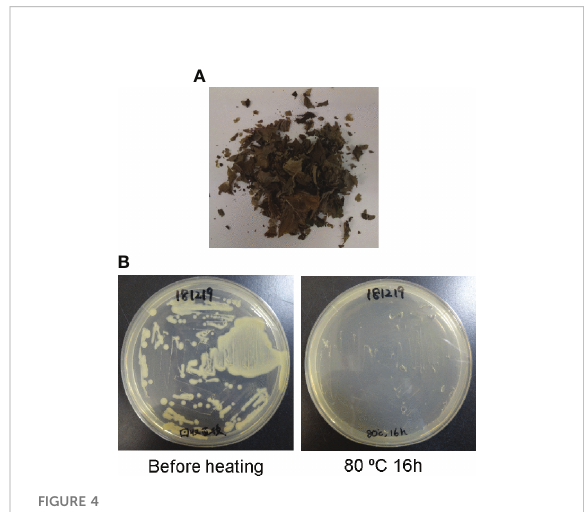
FIGURE 4 Agrobacterium was killed by heat treatment (80°C, 16 h). (A) After incubation at 80°C, the leaves were completely dried. (B) After agro-in fi ltration, Agrobacterium was alive in N. benthamiana leaves (before heating). After incubation of leaves at 80°C for 16 h, no bacterium survived in the AB medium with